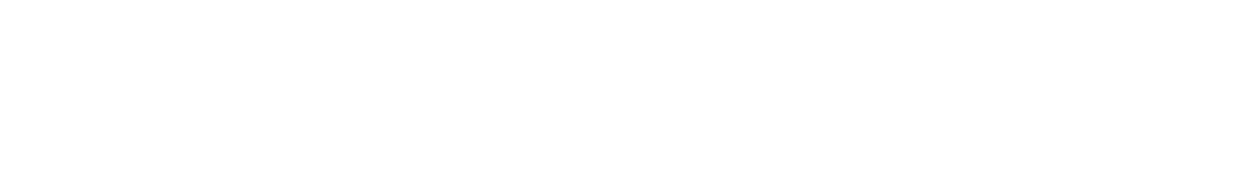
FIGURE 15 | Top left is truth; bottom left is RAI. For the other three columns, the top is eight wells and the bottom 36 wells. Left to right: mean, uncertainty, and simulation from Ember algorithm.